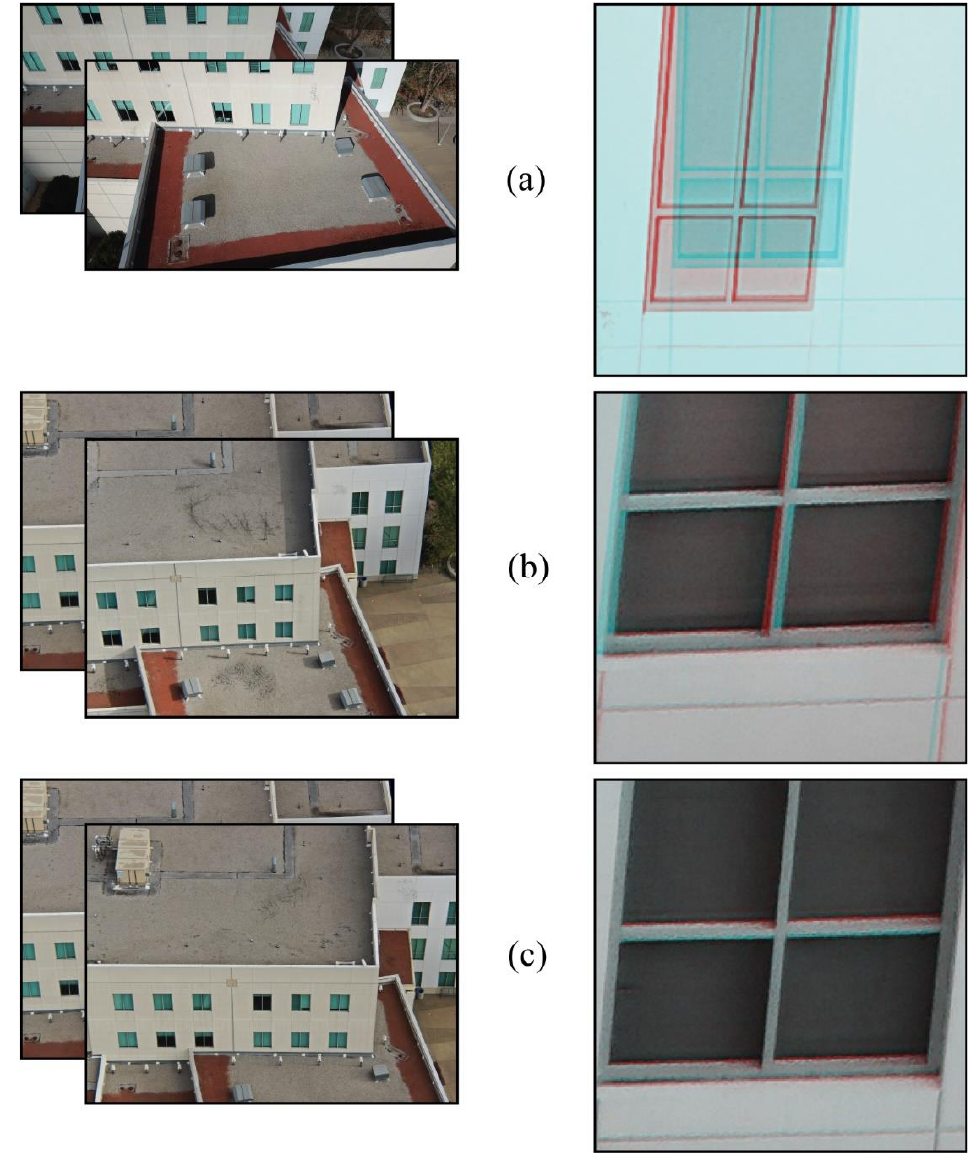
Figure 5. Examples of image co-registration products. Images on the left are the baseline and time- n pairs, and on the right are the co-registration results where red/cyan indicate mis-registration and illumination differences between images. ( a ) shows an example from the Mavic 1, ( b ) is an example from the Matrice 300 using the non-RSI collection method, and ( c ) is an example of the Matrice 300 using the RSI collection method.